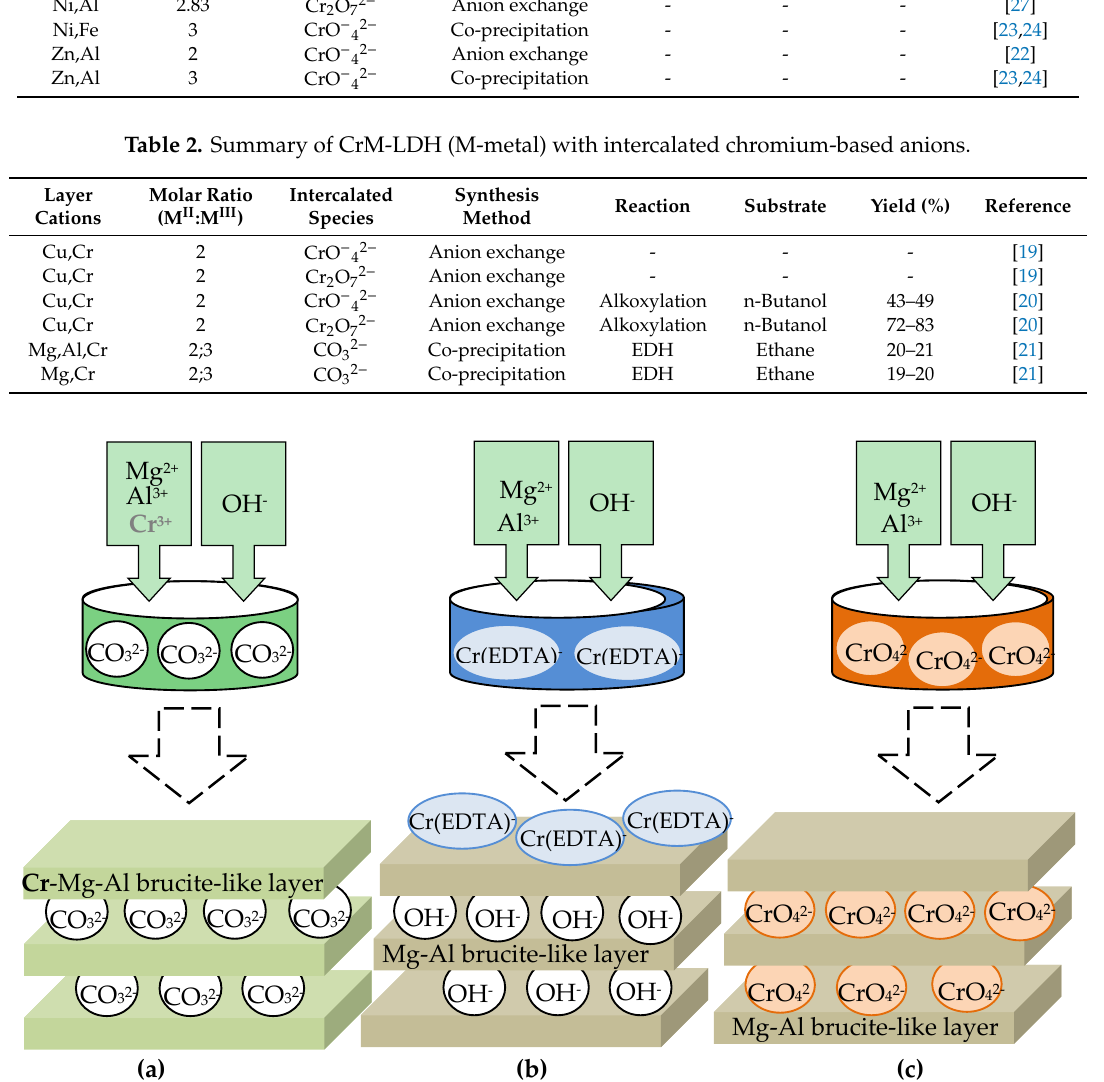
Figure 5. Synthetic approaches for the preparation of LDH precursors of chromium catalysts. Adapted from Ref. [21], Copyright 2007,